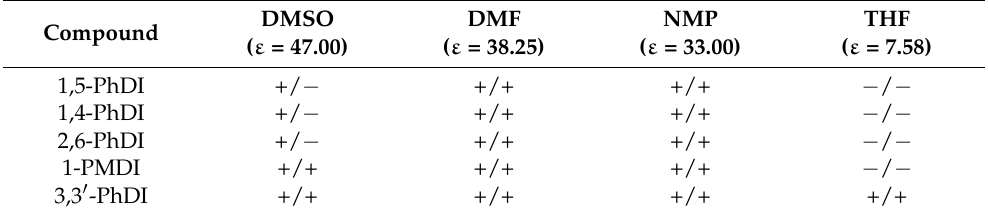
Table 1. Solubility tests of investigated imides.